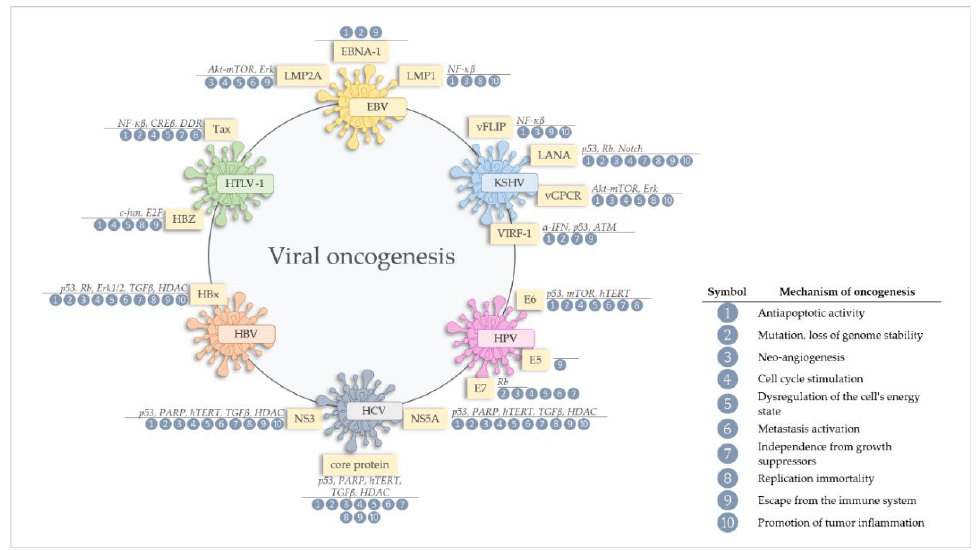
Figure 1. Mechanisms of oncogenesis and the involvement of viral oncoproteins in gastric cancer. All virus-associated tumors result from the cooperation of many oncogenic mechanisms. In gastric cancer, viral oncoproteins are triggering all (1 – 10) of the described oncogenic scenarios.